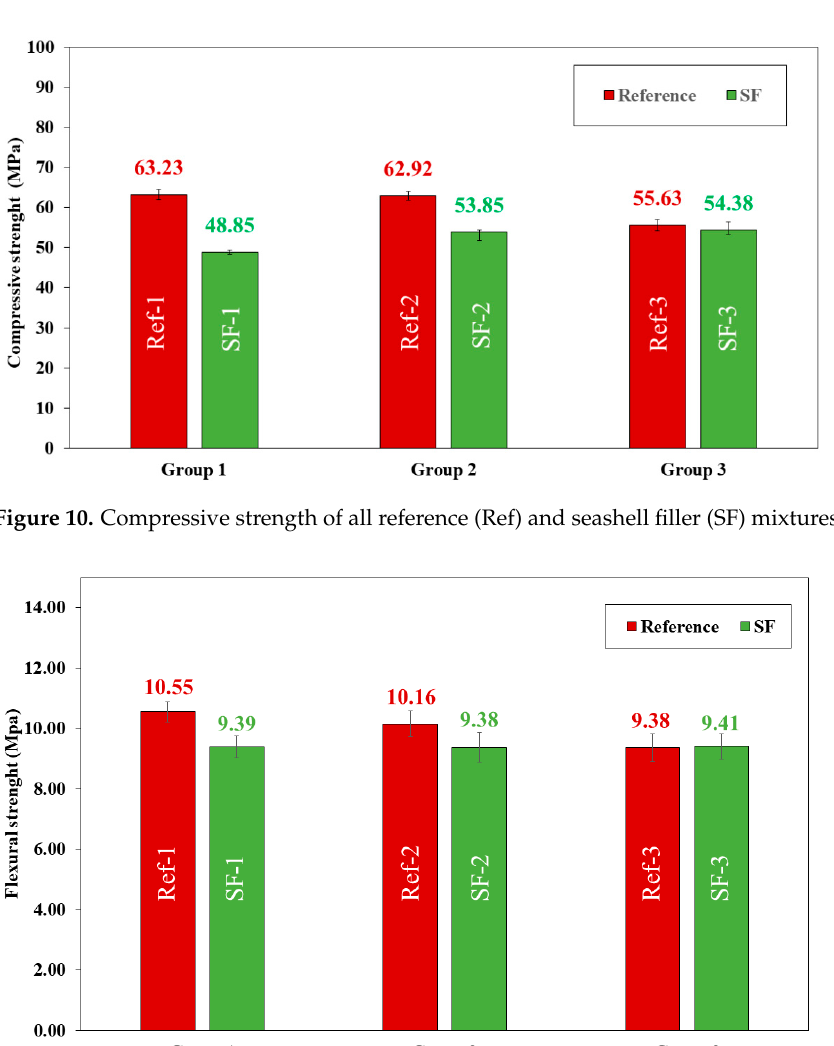
Figure 11. Flexural strength of all reference (Ref) and seashell filler (SF) mixtures